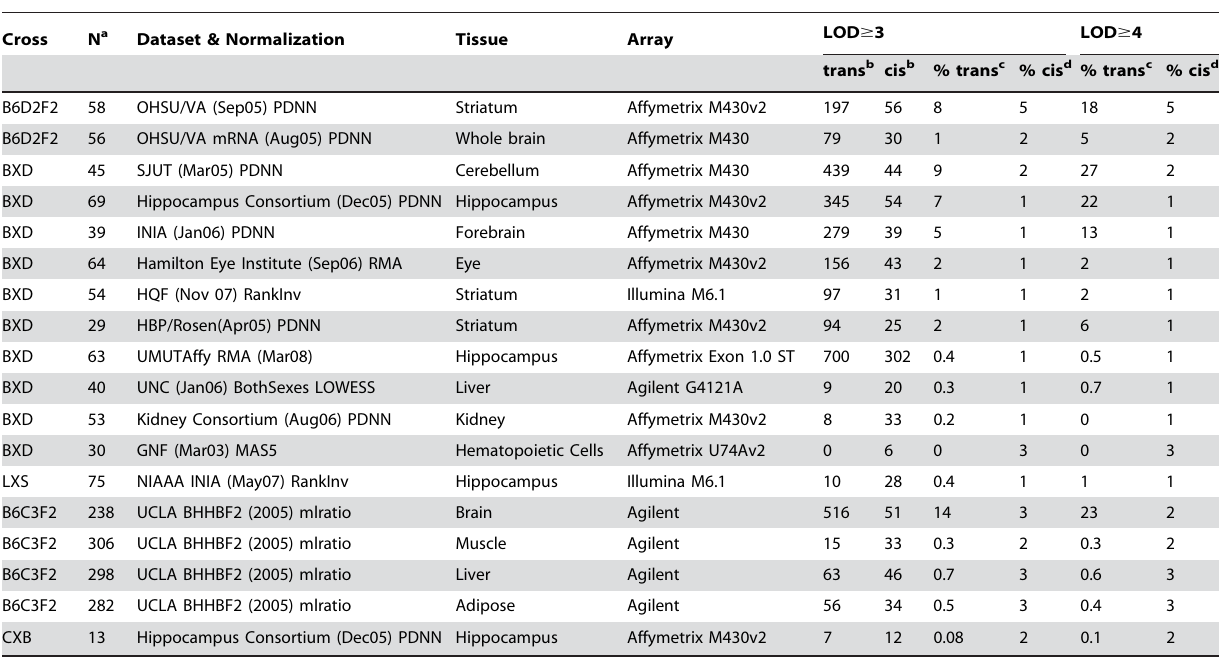
Table 2. Expression QTLs in Qrr1 in different crosses and tissues.